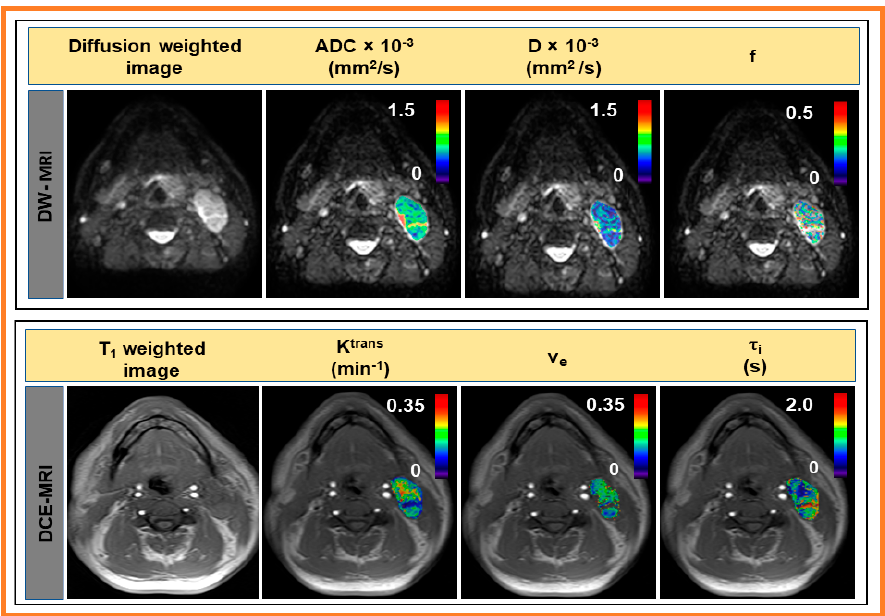
Figure 4. Top: Representative diffusion-weighted image (b = 0 s/mm 2 ) and monoexponential and intravoxel incoherent motion models-derived parametric maps overlaid on diffusion-weighted image (b = 0 s/mm 2 ). Bottom: Representative precontrast T 1 weighted (T 1 w) image and fast exchange regime model-derived parametric maps overlaid on precontrast T 1 w images.